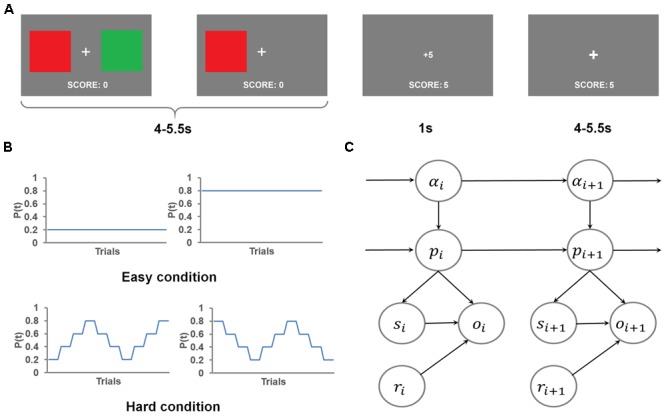
Task, experimental design and the graphical representation of the flexible learning model. (A) An example trial. Two color squares were presented on the screen for an interval, during which the red square was chosen, causing the green square being removed from the screen. The choice of the red square resulted in a gain of five points, which was displayed on the screen after the interval. The trial ended with a presentation of a fixation cross. (B) The four different time courses of the probability of getting high reward by selecting the red square used in this task. (C) The graphical representation of the generative model. Each node represents the state of a model variable. The edges show the flow of the information.